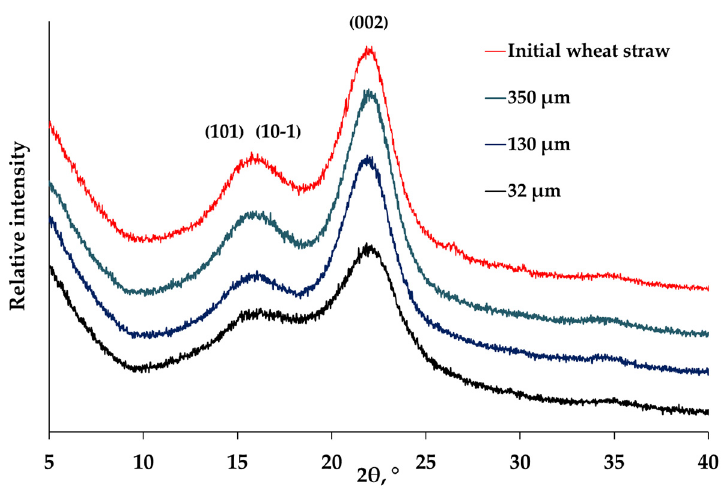
Figure 3. X-ray diffraction (XRD) patterns of wheat straw cellulose after mechanical activation and separation.